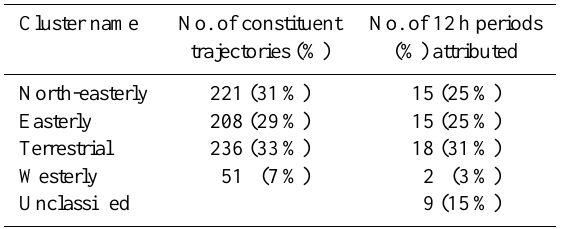
Fig. 3. R 2 , RMS and number of major clusters (containing > 3% of trajectories) as a function of number of clusters in solution for (a) OP3-I and (b) OP3-III. Solid lines are for one subset of trajectories and dashed lines are for the other.